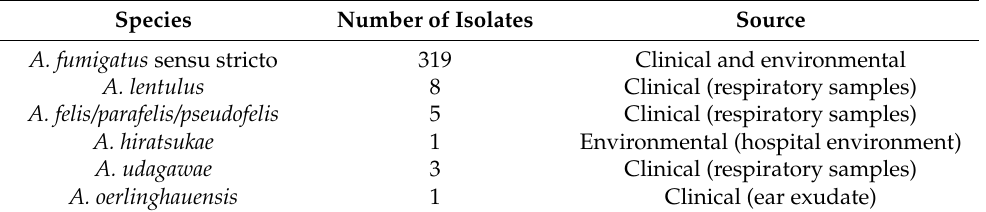
Table 3. Aspergillus species from Fumigati section collected in the period